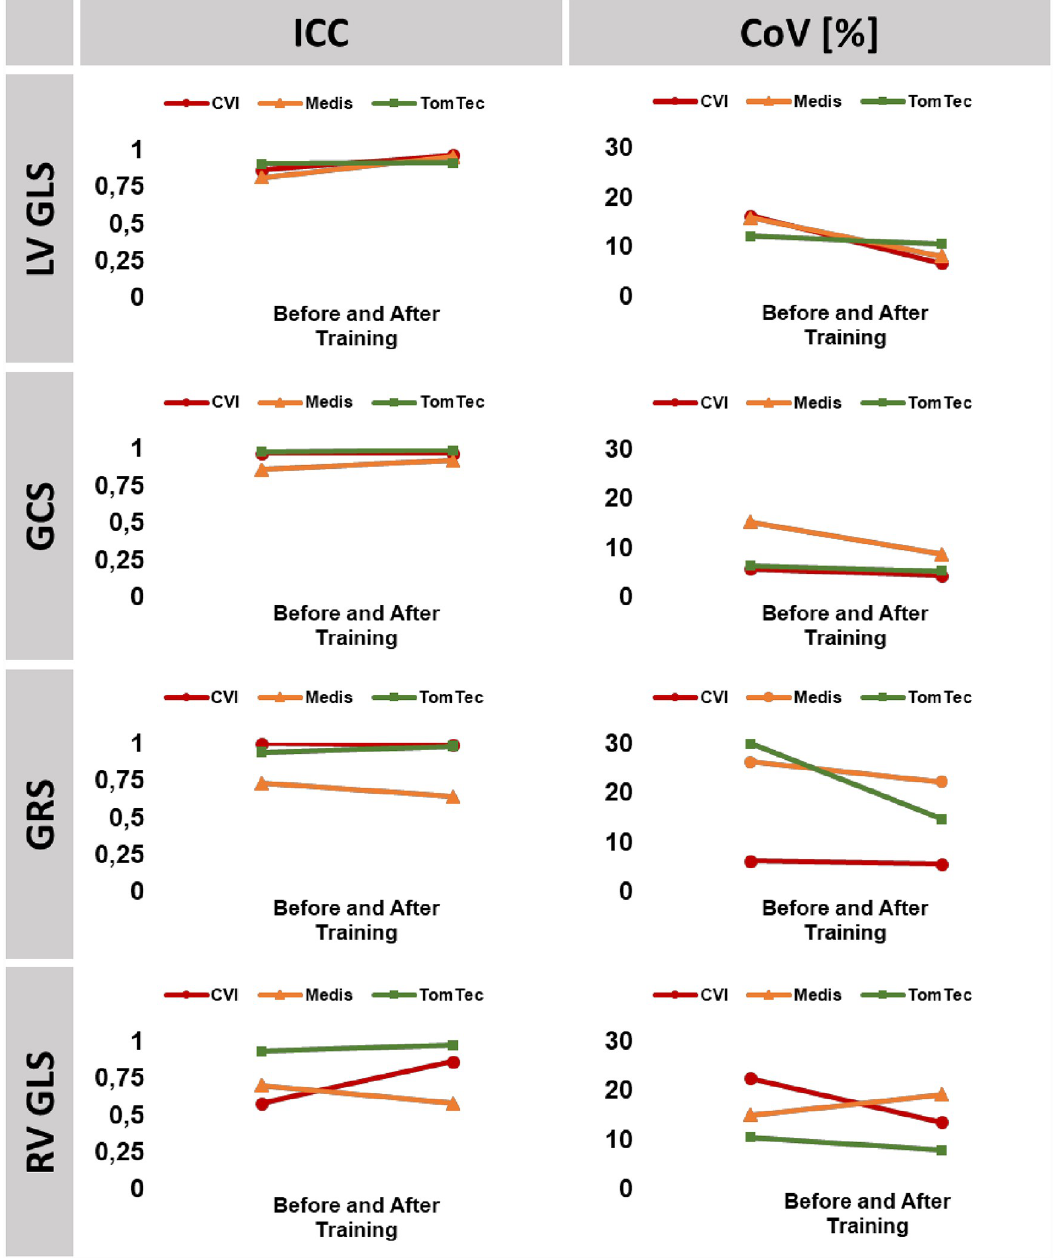
Fig 3. Inter-observer reproducibility. The graph shows interclass correlation coefficients (ICC) and coefficients of variation (CoV) for inter-observer reproducibility prior to and after training. LV/RV: left/right ventricle, GLS: global longitudinal strain, GCS: global circumferential strain, GRS: global radial